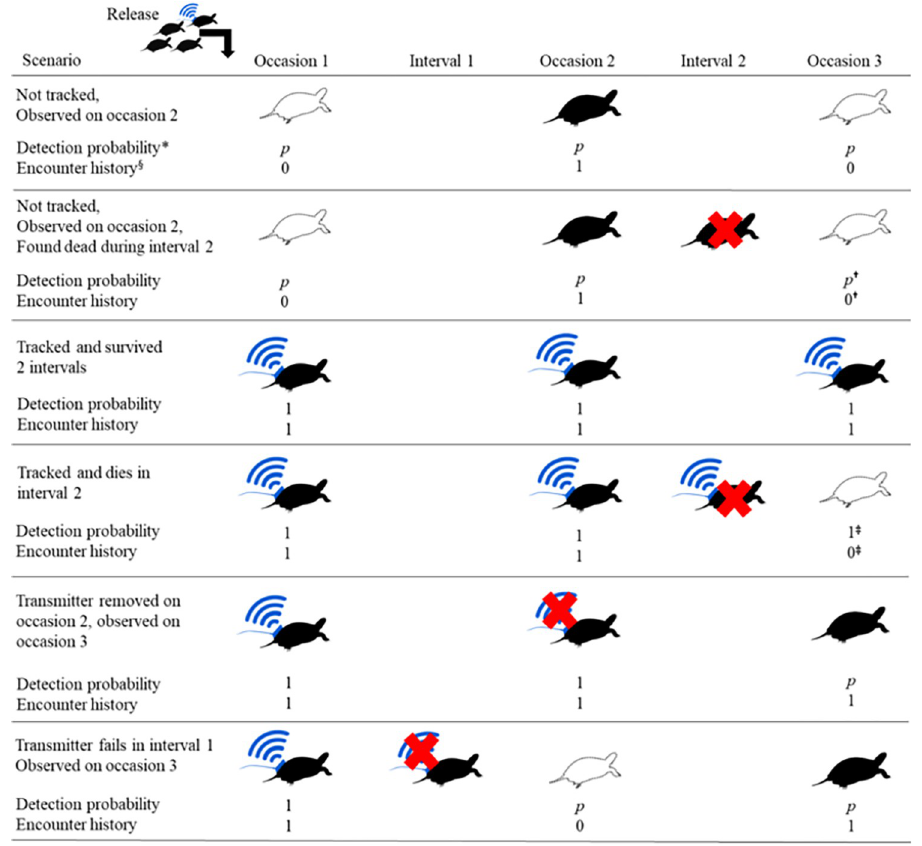
Fig 3. Conceptual diagram of how survival, telemetry, and detection were represented in encounter histories and using parameter fixing of detection probability, p , for a subset of potential scenarios. Scenarios are illustrated for a single Blanding’s Turtle release cohort over three sets of annual surveys. Hollow turtle symbols indicate an individual was not observed, a solid turtle symbol indicates that the turtle was observed. The red X indicates mortality, and the blue “wifi” symbol indicates a radio transmitter. Sampling by trapping and opportunistic detection were collapsed into one occasion per year with survival occurring during intervals between occasions. Telemetry observations of live individuals in May were considered live encounters during the corresponding annual occasion; otherwise, we considered telemetry observations during the rest of the year to occur during intervals, which are not represented directly in encounter histories. � Detection probability is conditioned on survival; † Jolly Seber models use only live encounter data, even when mortality is observed; § Encounter history is a binary sequence: 1 when an individual is observed alive, 0 when not observed; ‡ Conditional on being released, turtles are encountered according to the product of current detection probability and previous survival. Certain detection ( p = 1) but no encounter, implies no survival over a previous occasion, which informs survival